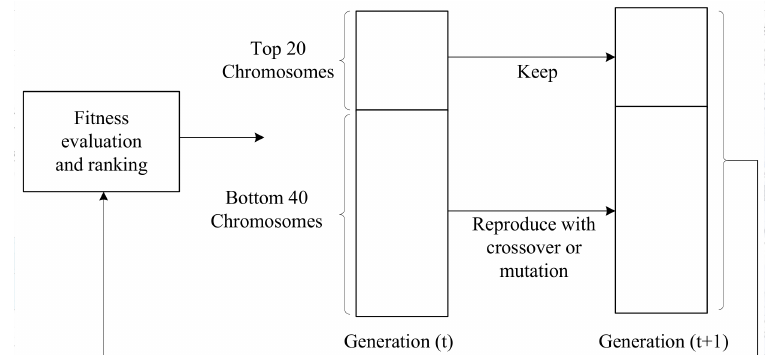
Figure 15. Reproduction of